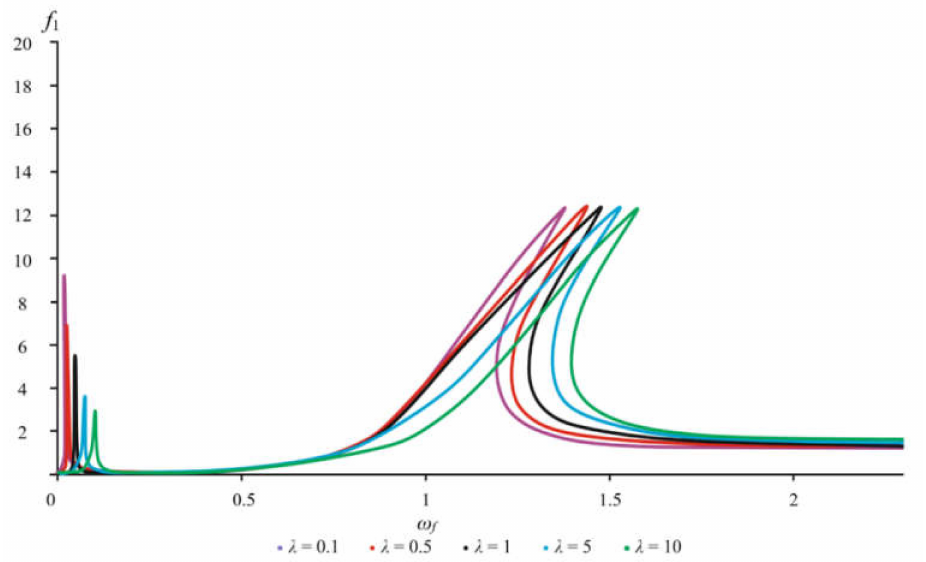
Figure 11. The amplitude-frequency characteristic of the rotor for different ratios of stiffness coefficients.